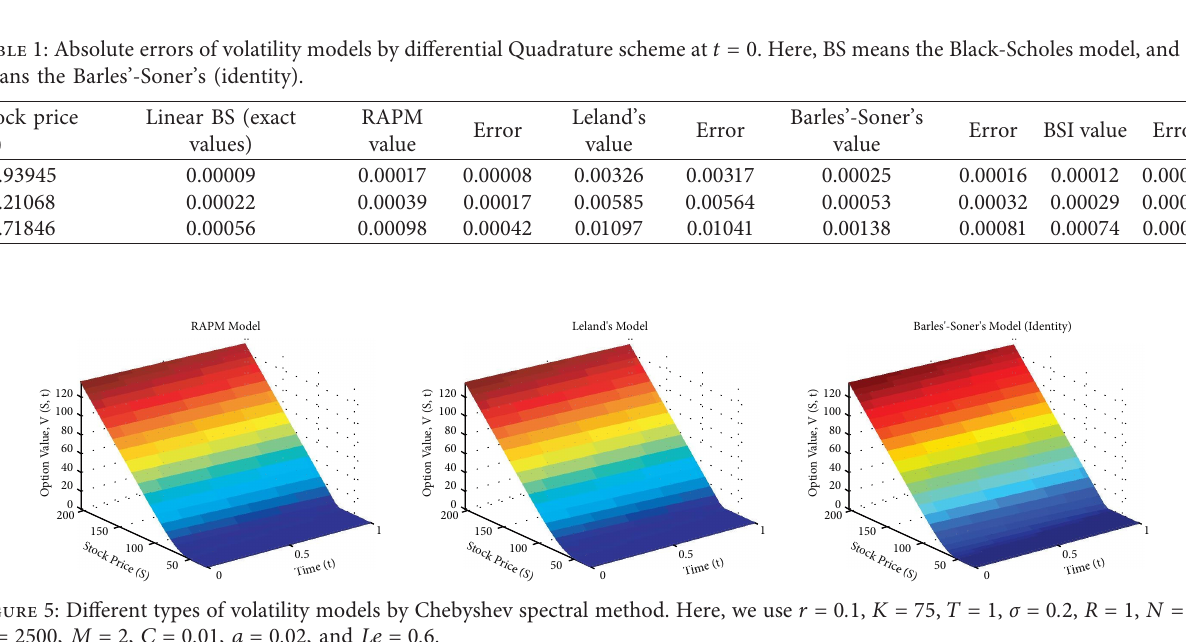
− V | considering volatility models by Chebyshev spectral method, where NL stands for nonlinear model NL L